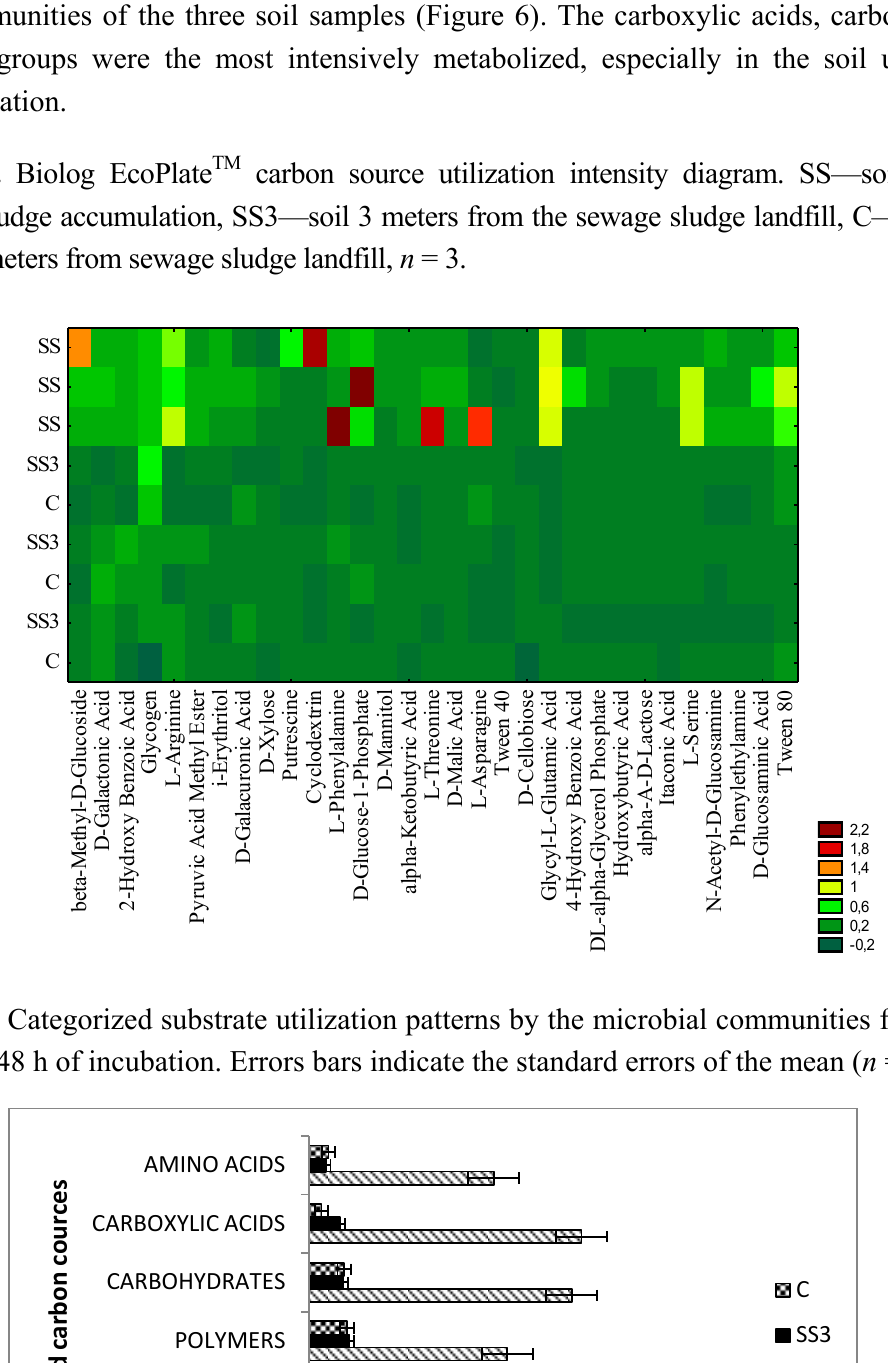
0.00 0.10 0.20 0.30 0.40 0.50